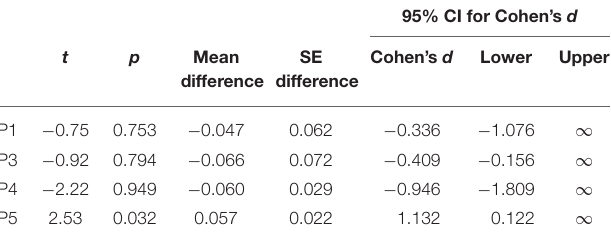
TABLE 4 | Frequentist paired sample t tests (H1 B ) on subject level.